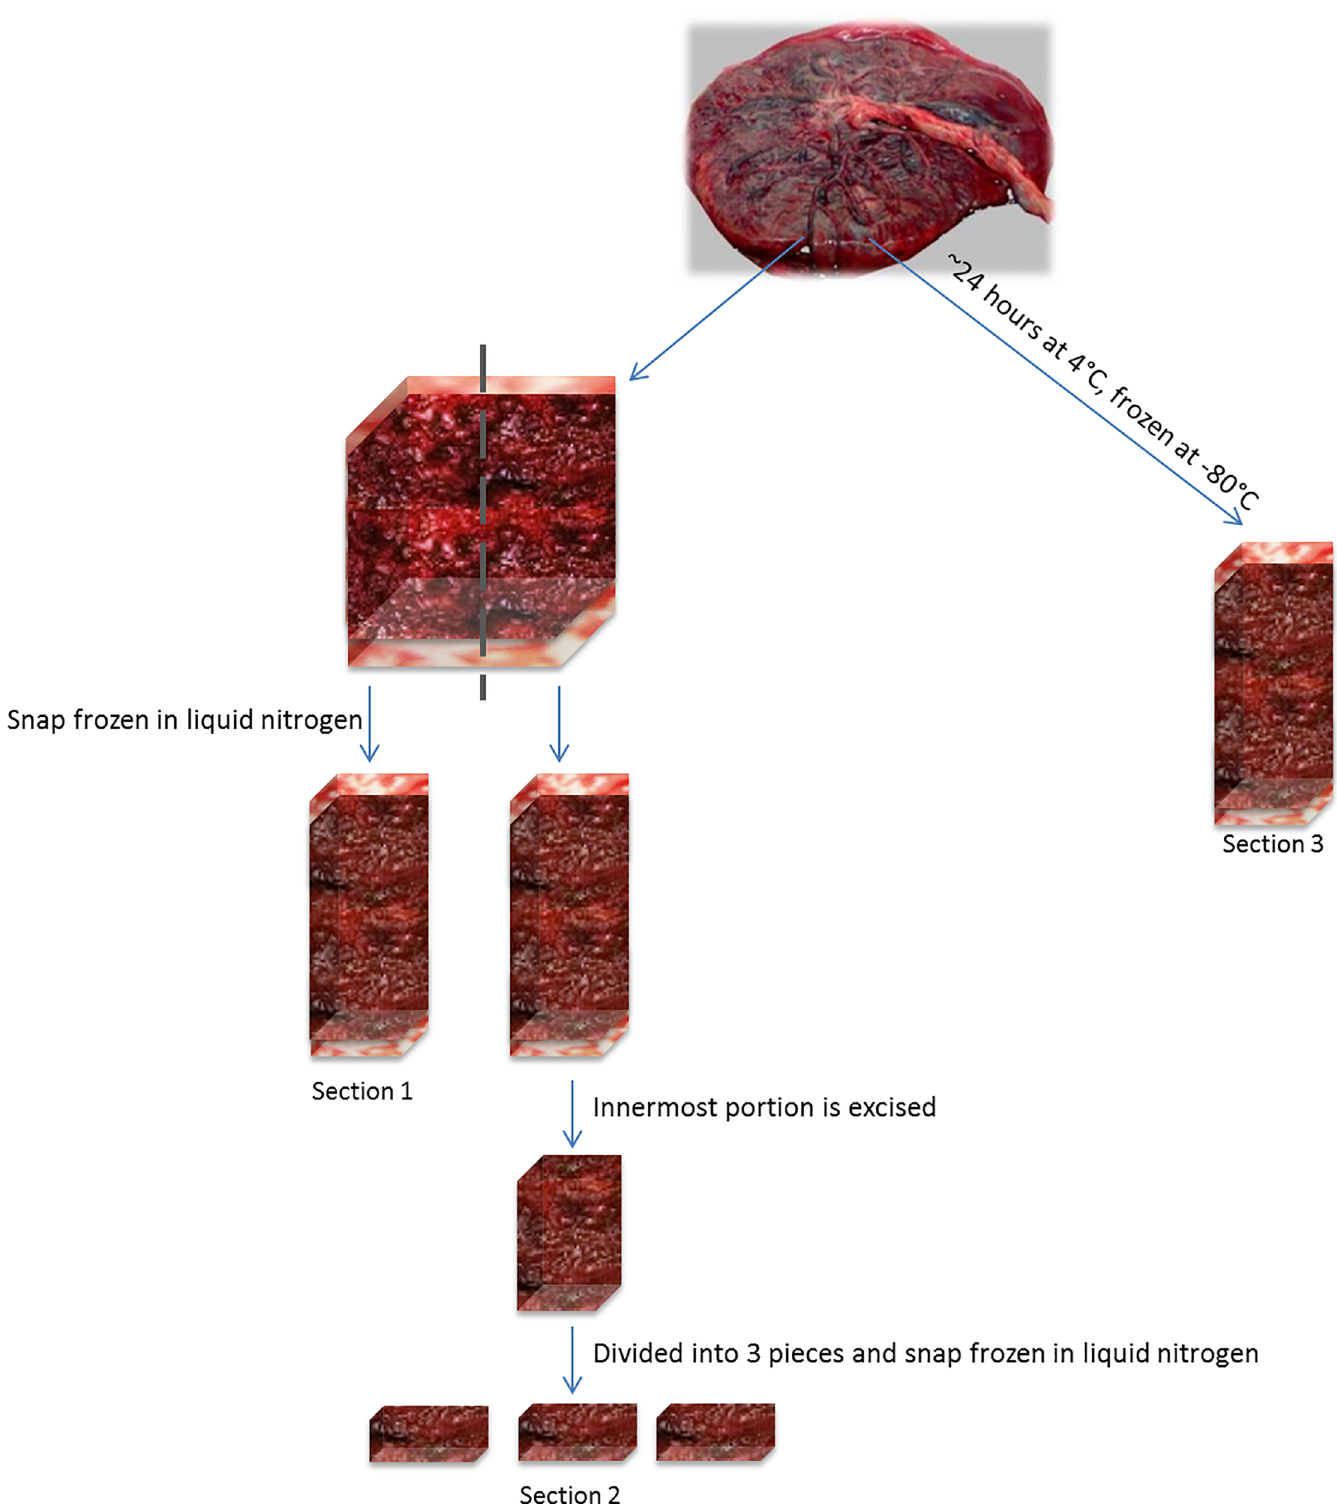
Fig 1. Tissue collection schematic. Tissues were collected using three different approaches: Section 1 was excised as a full thickness sample within 40 minutes of delivery and snap frozen in liquid nitrogen; Section 2 was excised within 40 minutes of delivery to the innermost portion of the placenta to reduce heterogeneity at the time of dissection and snap frozen in liquid nitrogen; Section 3 was collected 24 hours later after whole placenta refrigeration at 4˚C, then was dissected as a full thickness sample and frozen at -80˚C.